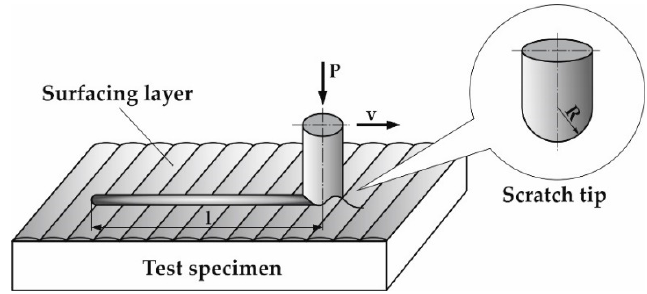
Figure 2. Schematic diagram of Inconel 625 nickel ‐ base superalloy surfaced layer scratch test .